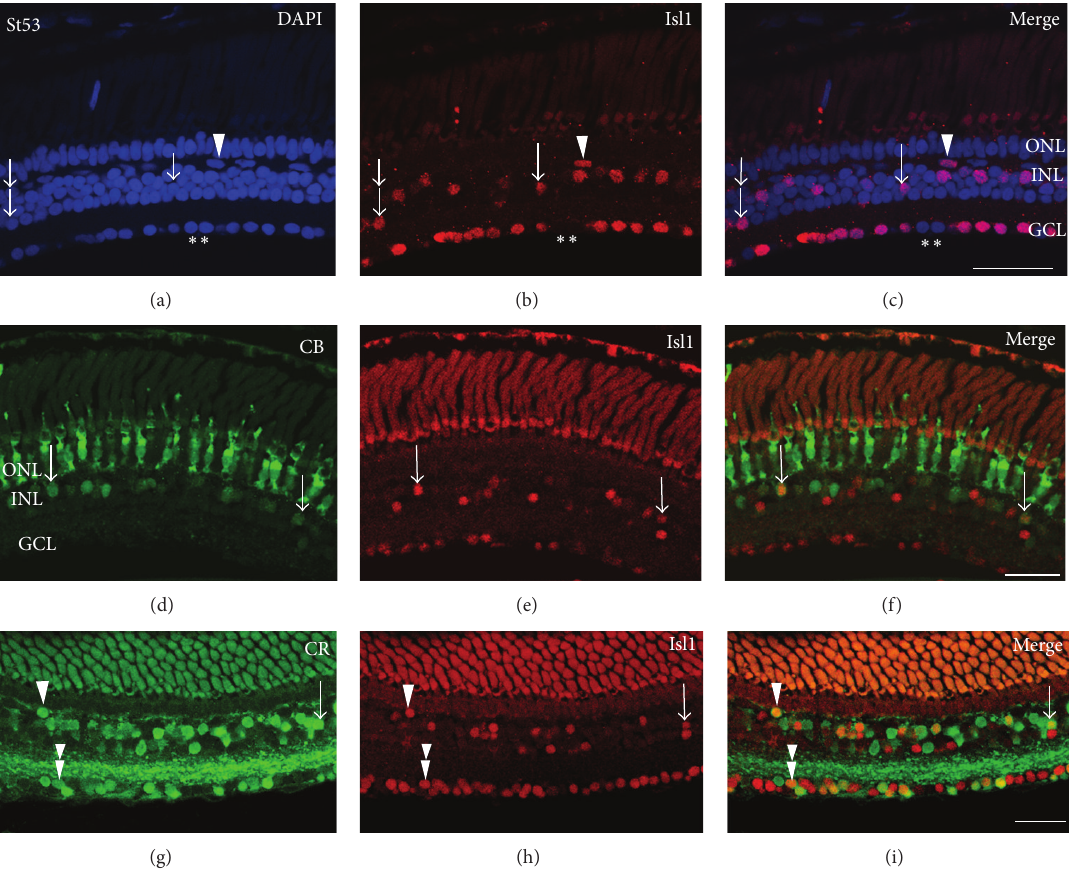
Figure 2: Morphological features and expression patterns of Isl1 and other cell differentiation markers in the St53 Xenopus laevis central retina.(a)–(c)DAPIfluorescencecombinedwithIsl1immunofluorescence.DAPIstainingshowedwell-organizedretinallayers.Isl1expressing cells in the INL could be characterized morphologically and topographically as horizontal (arrowheads), bipolar (arrows), or amacrine cells (double arrows). Notice that not all cells located in the GCL expressed Isl1 (asterisks). (d)–(f) A few Isl1-positive bipolar cells also expressed CB (arrows). (g)–(i) Subpopulations of Isl1-positive horizontal (arrowheads), bipolar (arrows), and ganglion cells (double arrowheads) also expressed CR. GCL: ganglion cell layer; INL: inner nuclear layer; ONL: outer nuclear layer. Scale bars: 100 𝜇 m. Table 2: Immunoreagents, working dilutions, and sources of antibodies used in the present study. Working dilution Antibody suppliers (reference) Primary antibody Rabbit anti-bovine rod opsin polyclonal antibody,